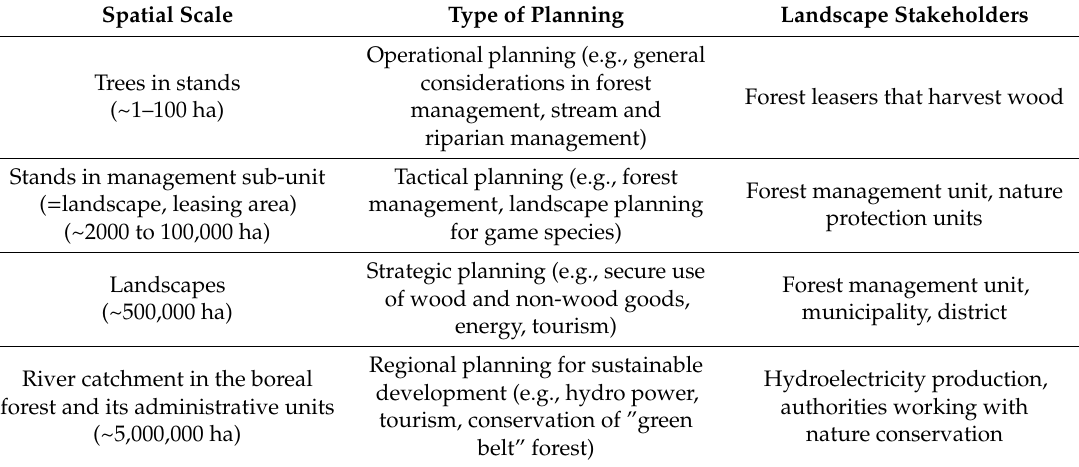
Figure 7. Representation of the spatial scales of stakeholders’ activities in the lower part of Kovda River catchment. Table 4. Spatial scales for different types of planning identified from interviews with 31 categories of users of forest landscapes’ goods, services and values in the lower part of the Kovda River catchment, as determined by the stakeholders’ use profiles.